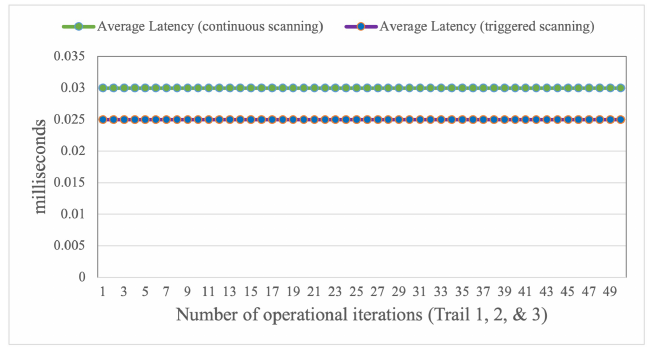
Figure 5. Average Latency impact on Tizen mounted devices.